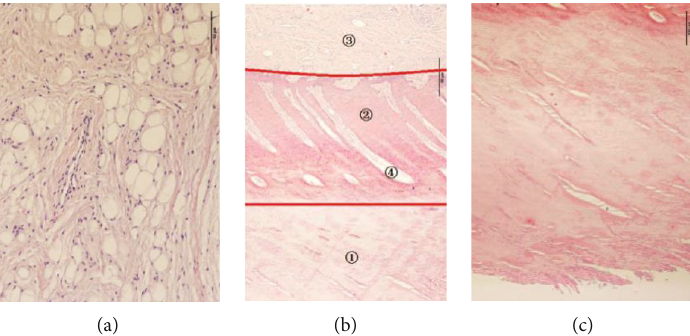
Figure 4: Histological images of hoof bulbs: (a) subcutaneous connective tissues, (b) longitudinal sections of bulb tissues, and (c) epidermis layer. ① : epidermal layer; ② : dermal layer; ③ : subcutaneous connective tissues; ④ : dermal